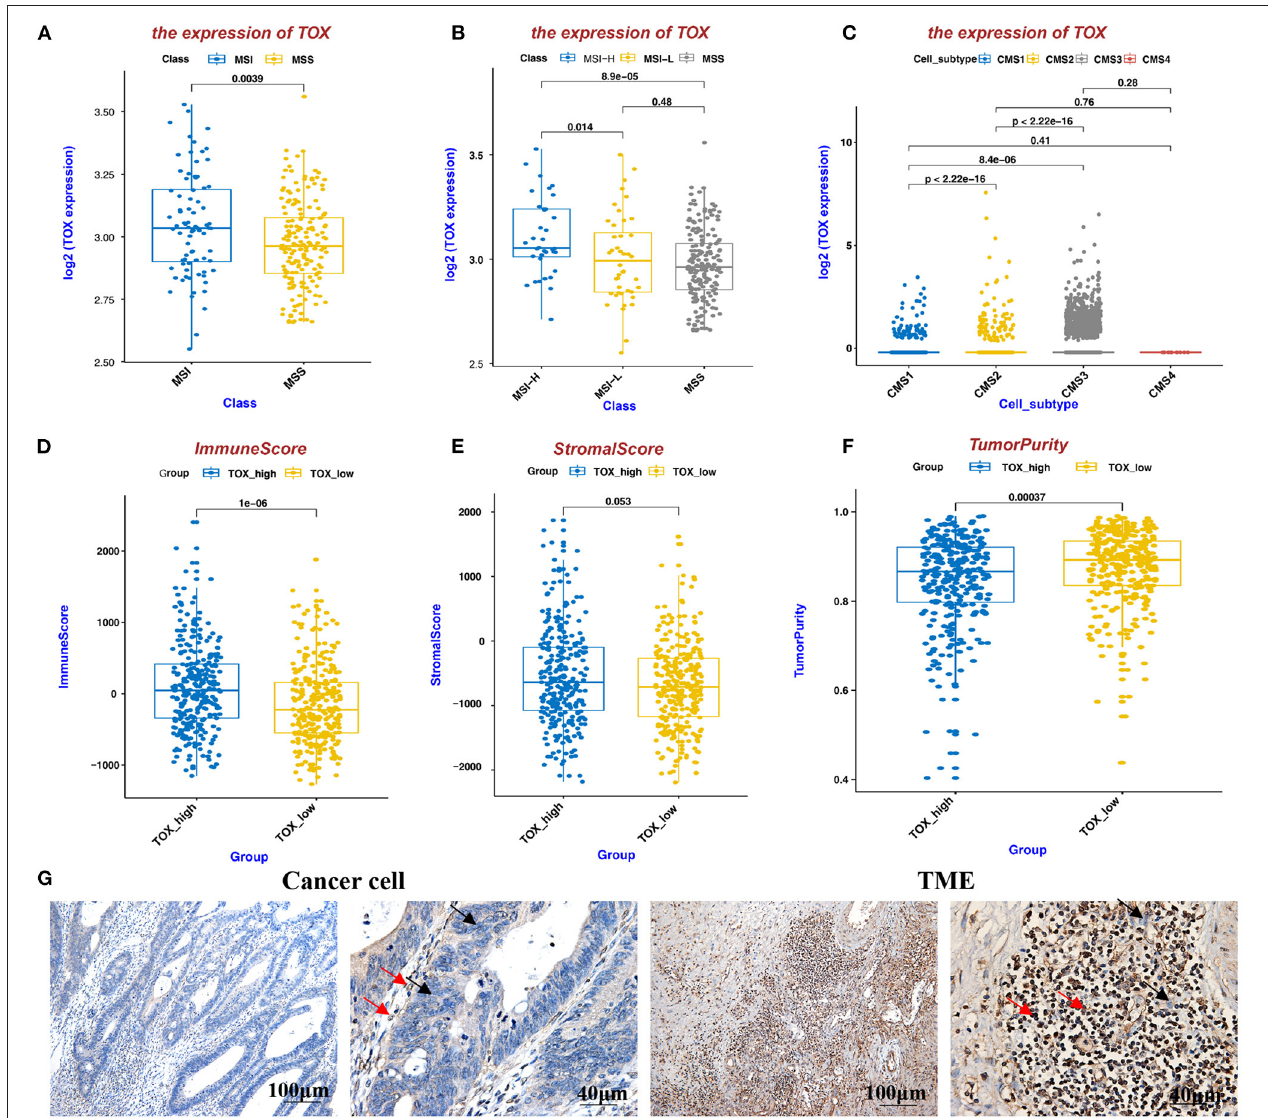
FIGURE 2 | TOX expression is higher in MSI CRC than in MSS CRC, positively correlates with ImmuneScore and StromalScore, and negatively correlates with TumorPurity. (A,B) MSI status of TOX-low and TOX-high CRC tumors. (C) TOX expression in different CMS subtypes. (D–F) The relationship between TOX expression and ImmuneScore (D) , StromalScore (E) , and TumorPurity (F) in CRC patient (inferred by ESTIMATE algorithm). (G) TOX expression was shown in cancer cells and the TME by IHC. Black arrows represent tumor cells, red arrows represent immune